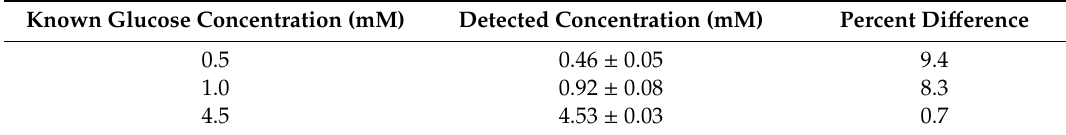
Table 1. Comparison of known glucose concentrations to glucose concentrations detected by analysis, with percent di ff